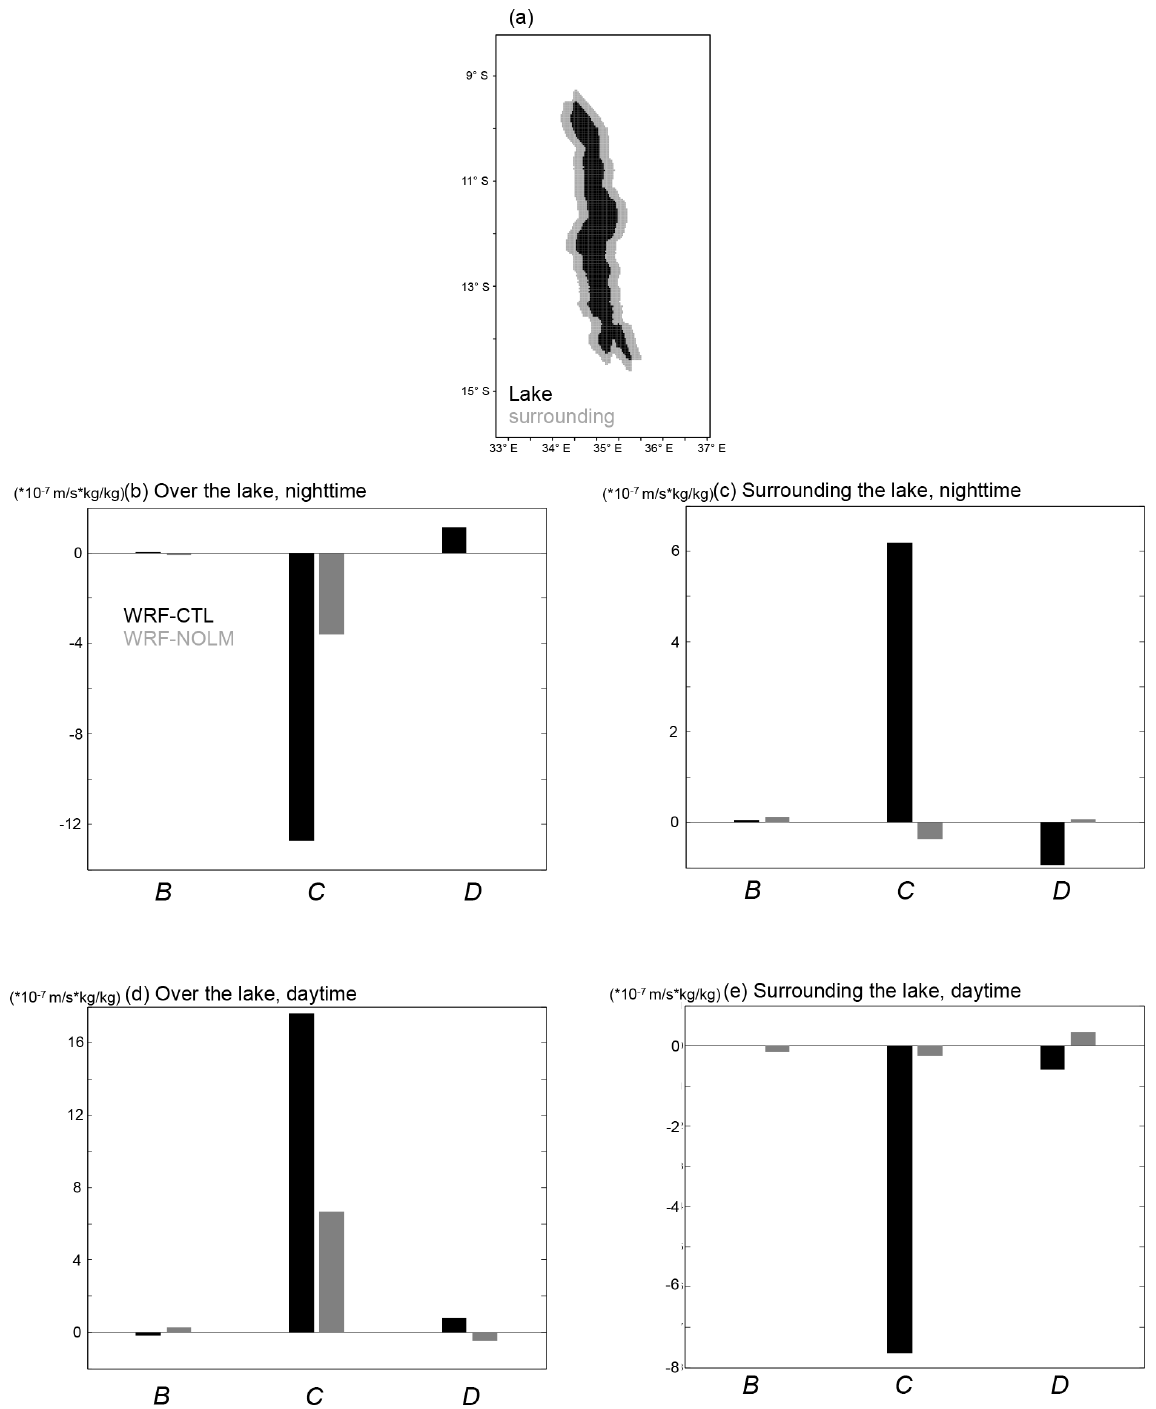
Figure 8. (a) Grids of the lake (black) and surrounding area (grey) for area-averaging. The area-averaged three components of moisture flux divergence in Eq. (3) for (b) over the lake, nighttime (00:00–01:00 to 02:00-03:00UTC), (c) surrounding the lake, nighttime, (d) over the lake, daytime (11:00–12:00 to 13:00–14:00UTC), and (e) surrounding the lake, daytime, for WRF-CTL (black) and WRF-NOLM (grey),